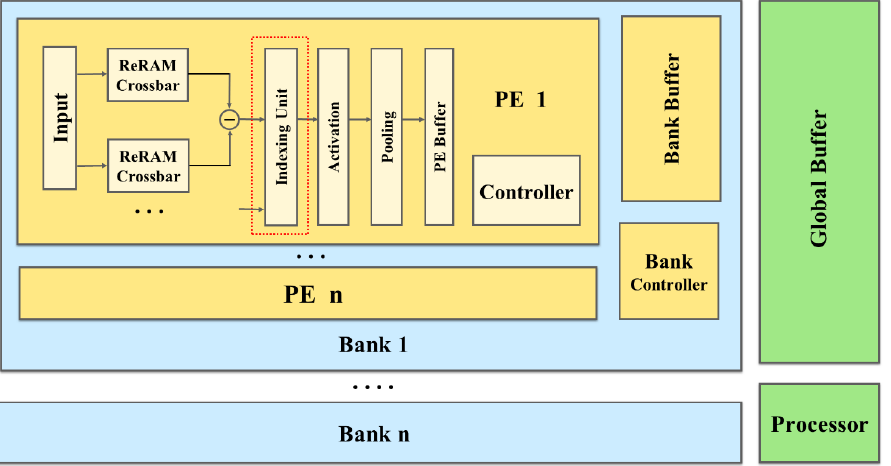
Figure 3. Skeleton of sparse NN mapping scheme system flow chart [7].